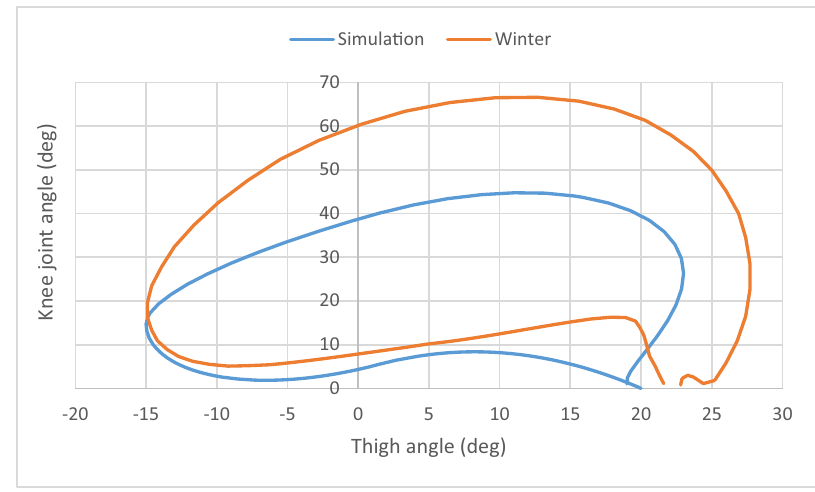
Figure 24: Cyclogram of simulation and Winter [ 8 ]